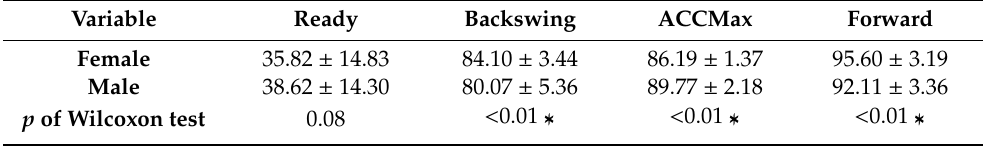
Table 1. The moment when cycle events occur in the test groups (in %, mean ± standard deviation (SD). Variable Ready